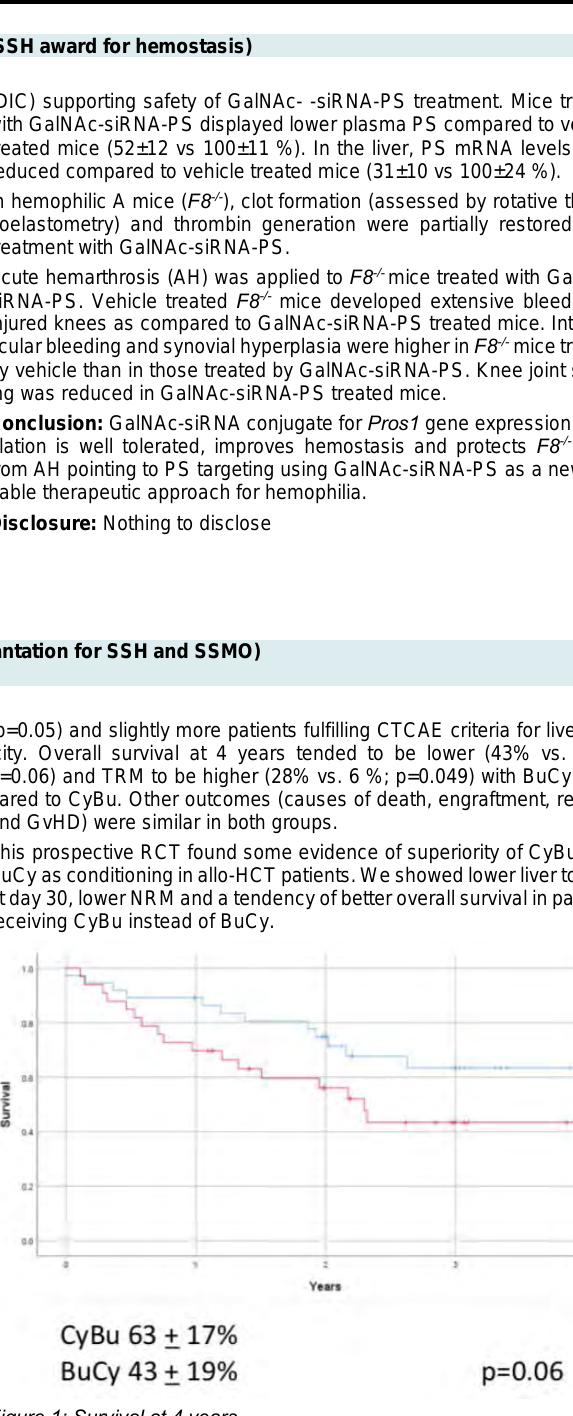
Figure 1: Survival at 4 years Disclosure: Conflict of interest: none Fundings: Baxter SA and Roba- pharm / Pierre Fabre